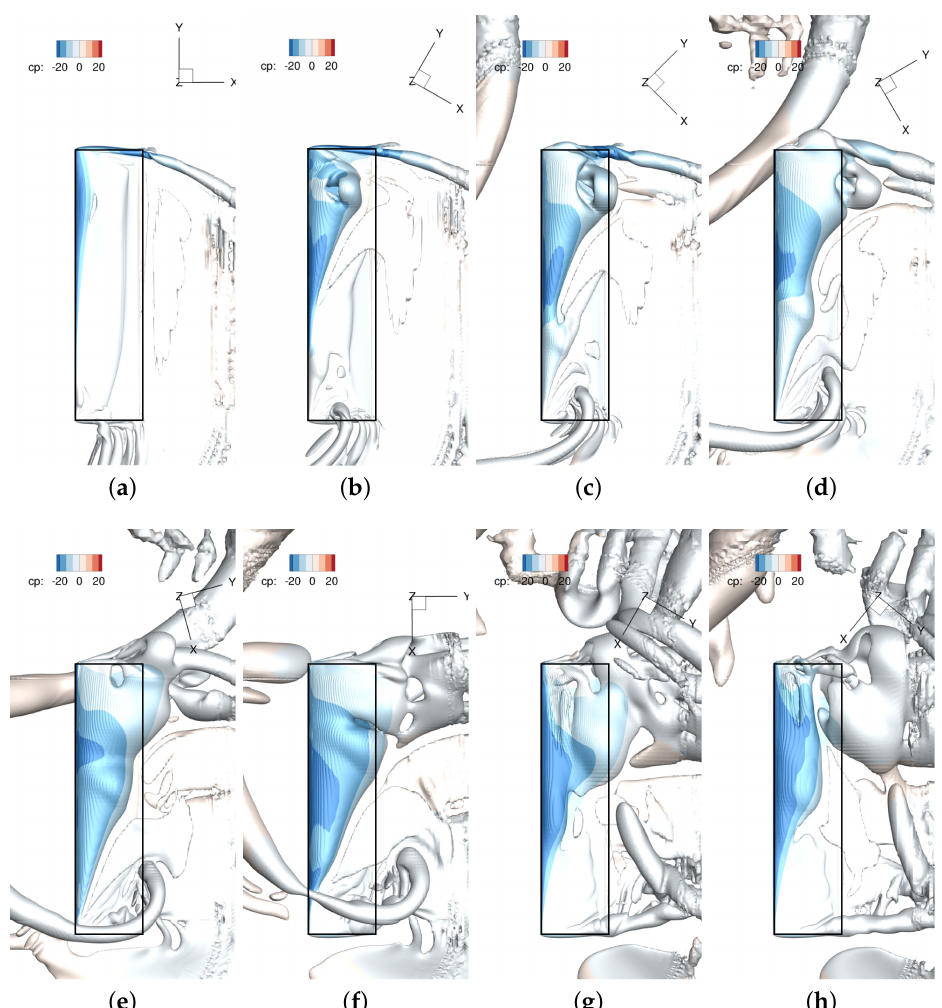
Figure 8. Vortex structure shown by iso-surface of Q criterion ( Q = 5000 s − 2 ) shaded by pressure coefficient cp referenced to forward flight speed. For each subplot, top: blade tip, bottom: blade root. The blade border is shown with the black rectangle. Azimuth positions: Ψ = ( a ) 270 ◦ ; ( b ) 300 ◦ ; ( c ) 315 ◦ ; ( d ) 330 ◦ ; ( e ) 345 ◦ ; ( f ) 0 ◦ ; ( g ) 30 ◦ ; ( h ) 39 ◦ . The inertial coordinate is plotted